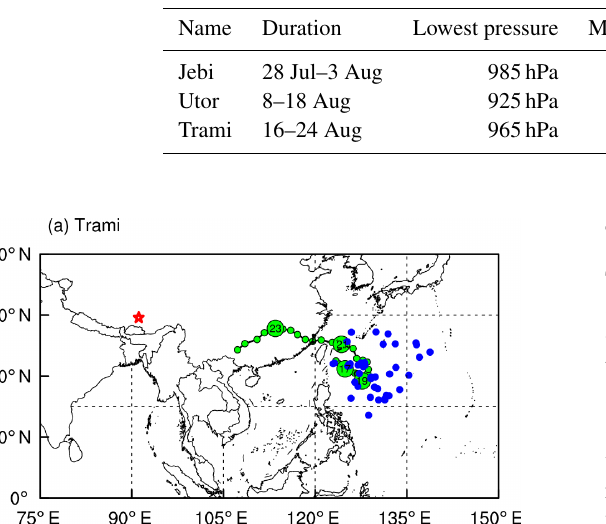
Table 2. Classification of tropical cyclones Jebi, Utor, and Trami in 2013.